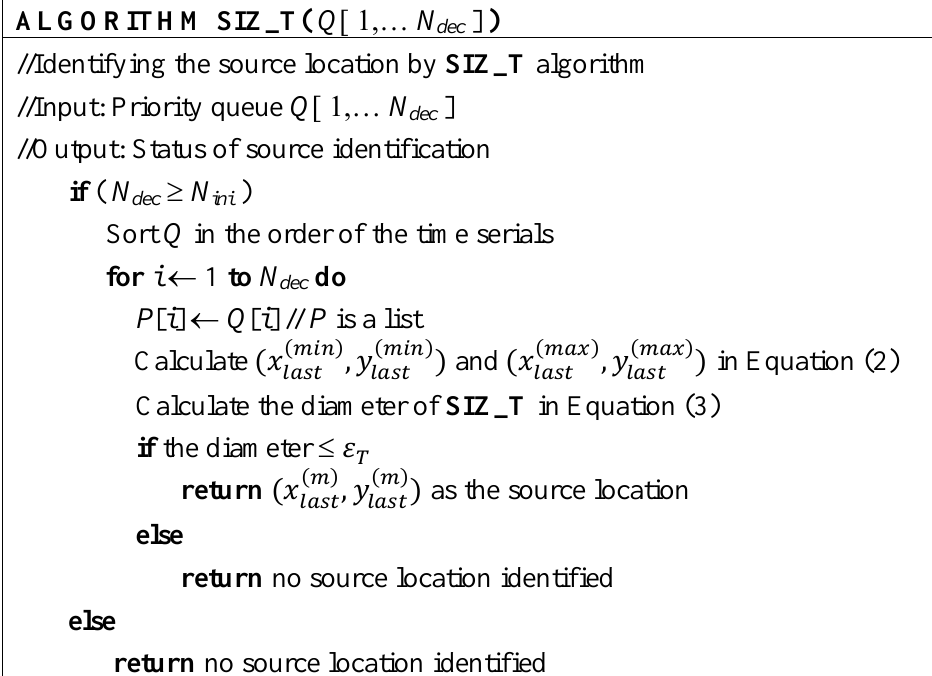
Algorithm 1. Pseudo Code of SIZ_T